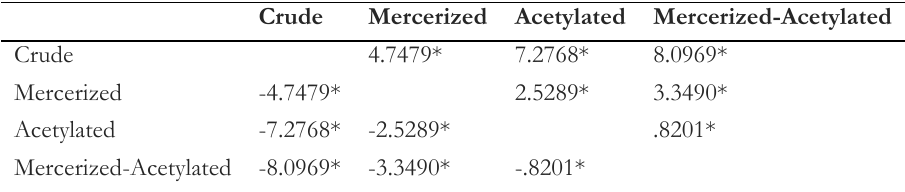
Table 9. Games H owell’s multiple comparison of percentage moisture absorption among various fibre